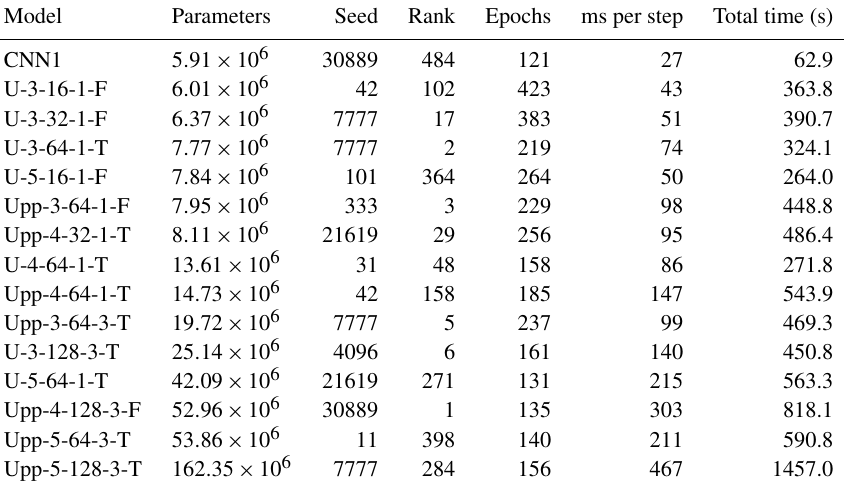
Table 3. Computational details of some of the models. Note that some models not shown before, like Upp-5-128-3-T , which was the largest model trained, are added for completeness. All the following calculations were carried out on a NVIDIA A-100 (40GB) GPU, with a batch size of 512, resulting in 20 steps per epoch. The table is ordered according to the ascending number of total parameters in the models.